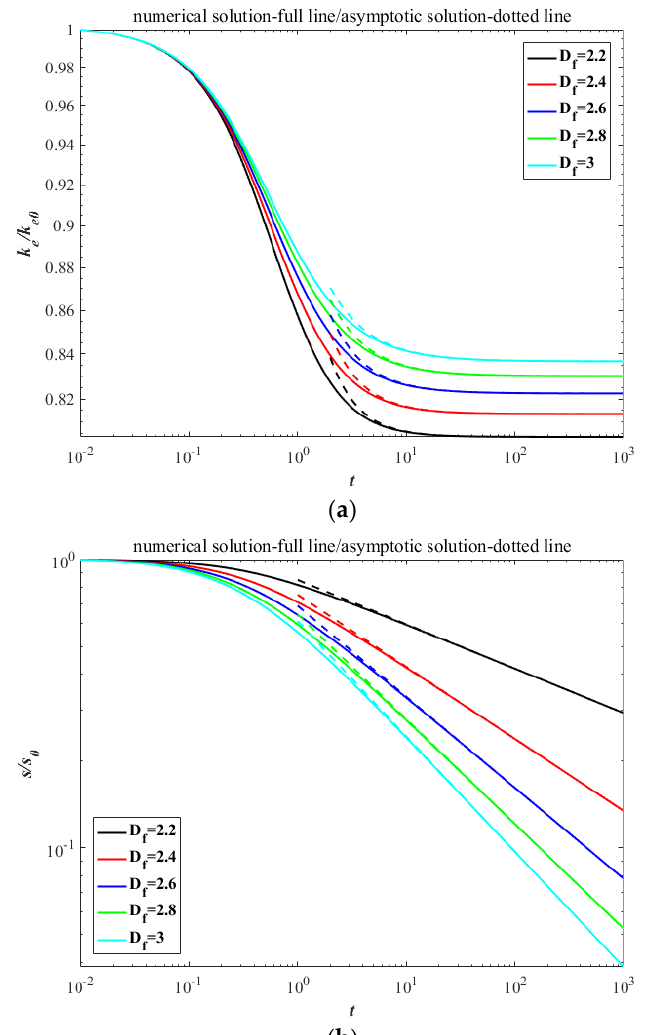
Figure 2. The decay with time between numerical solutions and asymptotic solutions in the free molecular regime: ( a ) kinetic energy; ( b ) surface